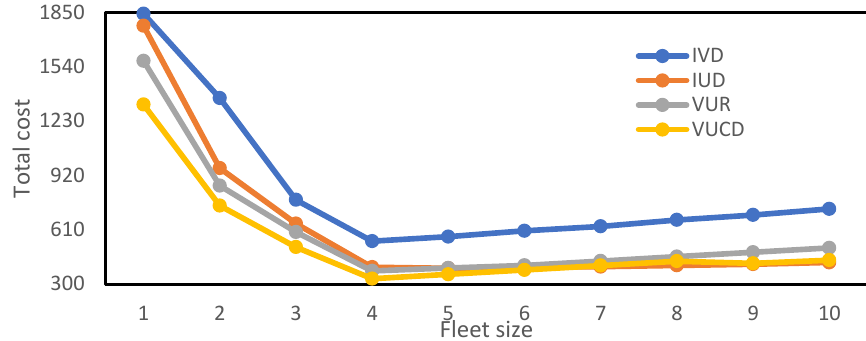
Figure 6. Total cost of different models.